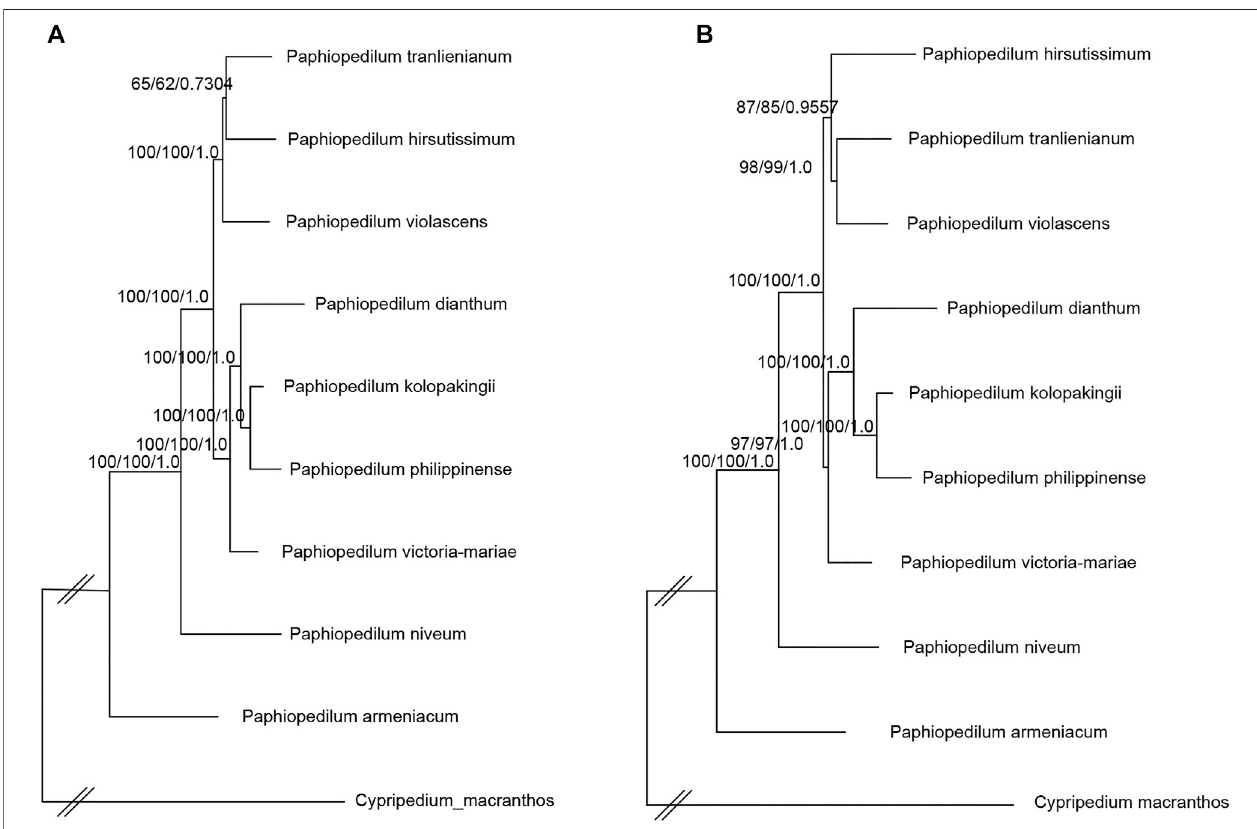
FIGURE 9 | Phylogenetic relationships of the nine Paphiopedilum taxa and one Cypripedium taxon constructed by each of the four DNA sequence alignment datasets, including whole cp genomes (A) , coding regions (B) , non-coding regions (C) , and ten hypervariable regions (D) using maximum parsimony (MP), maximum likelihood (ML), and Bayesian inference (BI) methods, respectively. ML topology is shown with MP bootstrap support values/ML bootstrap support value/Bayesian posterior probability listed at each node.